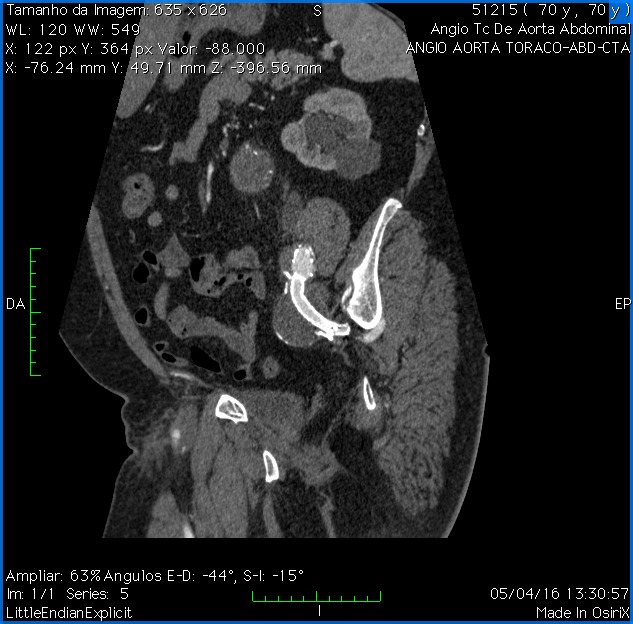
Sagittal control angiotomography showing exclusion of left internal iliac artery aneurysm with preservation of iliac branch patency.